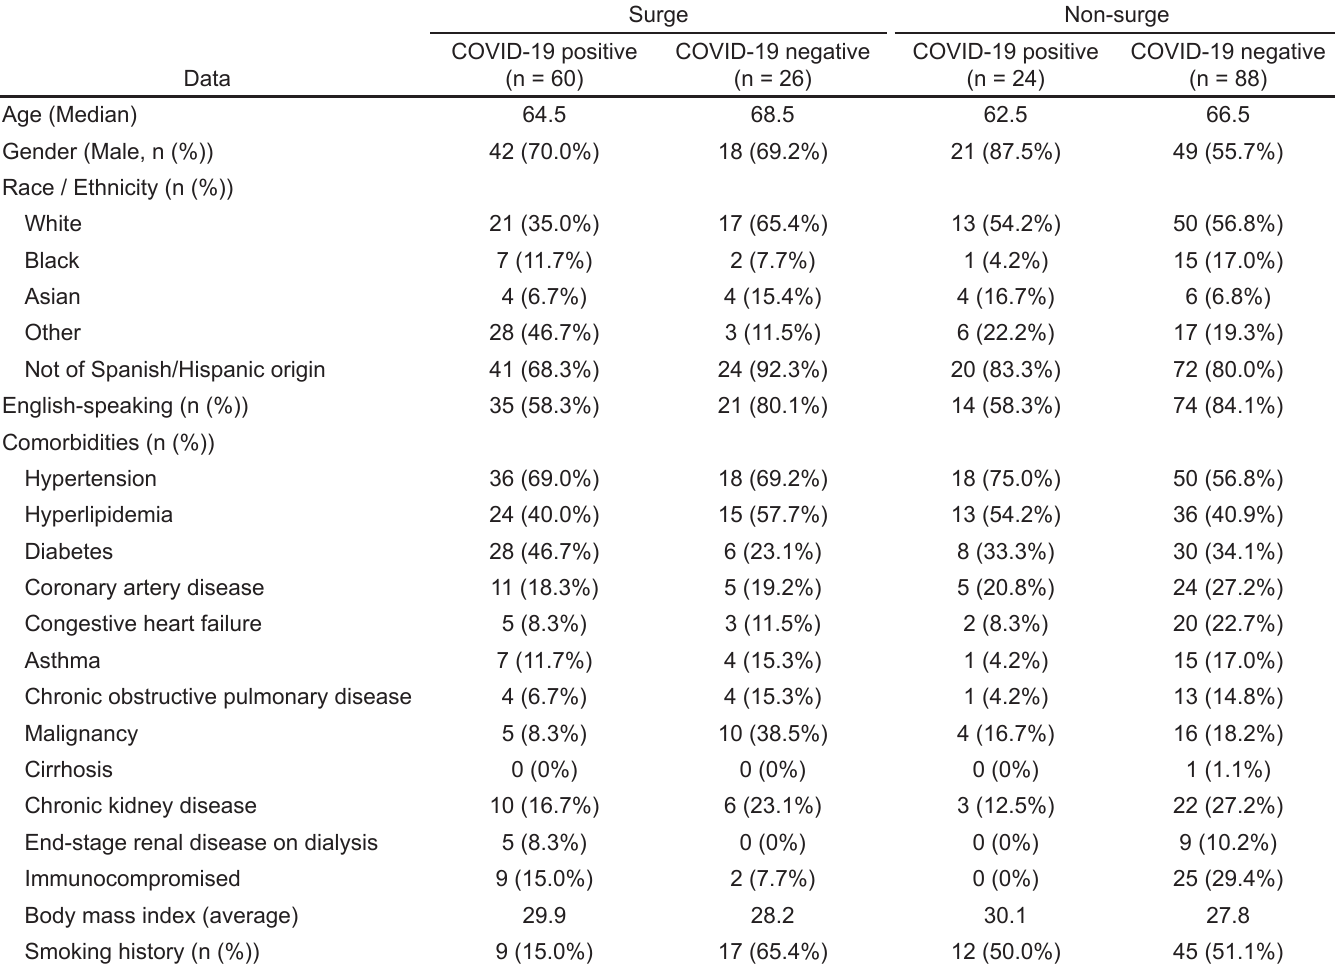
Table 1. Study population